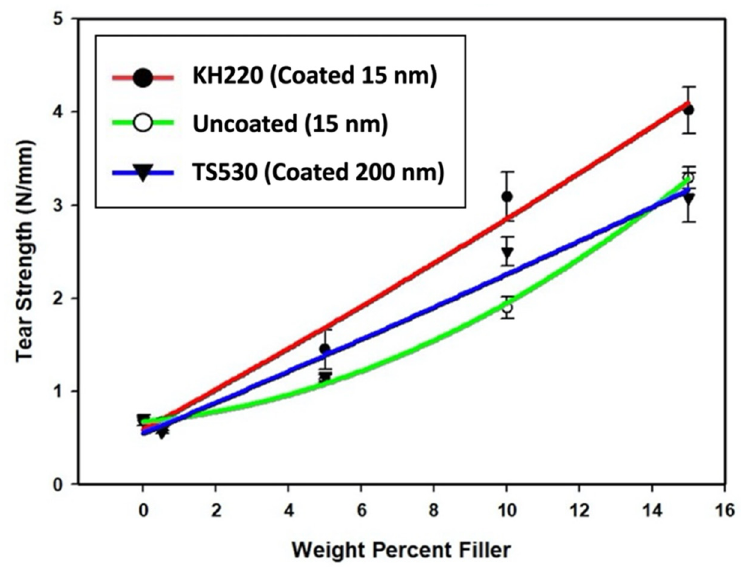
Figure 11. Plots of Tear Strength (N/mm) Versus Weight Percent Filler For Three Filler Types. Error Bars Represent Standard Errors of Means.